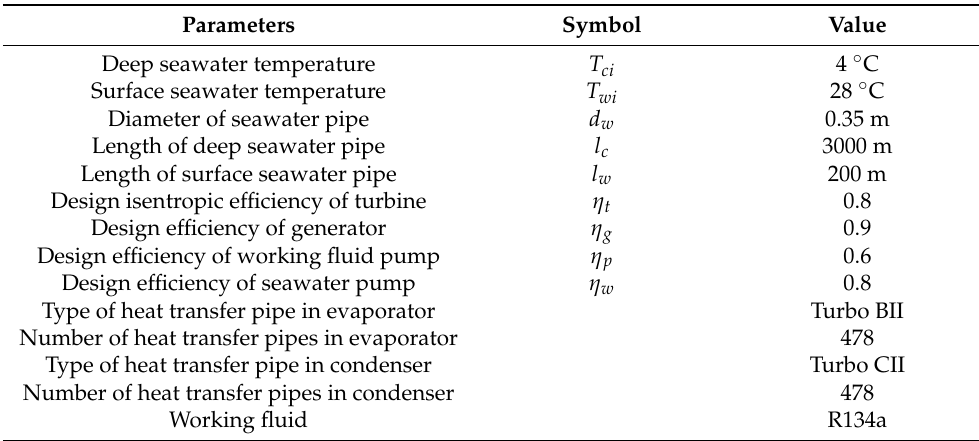
Table 1. The design